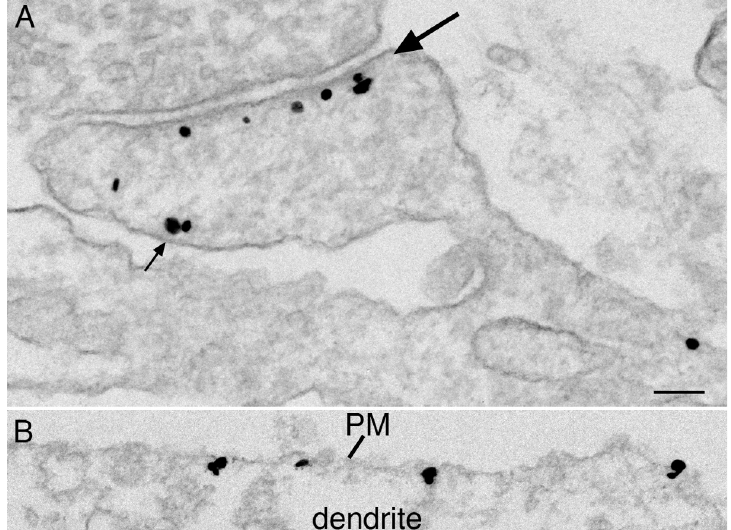
Fig 2. Densin immunolabel is concentrated at the PSD. Electron micrographs showing immunogold labeling of cultured hippocampal neurons using densin antibody 1. Silver-enhanced gold particles are seen as dark grains of heterogeneous size A : excitatory synapse showing intense labeling at the PSD (large arrow) with some labeling on the plasma membranes near the synapse (small arrow). B : dendritic region showing scattered labelling on the plasma membrane. Scale bar = 0.1 μ